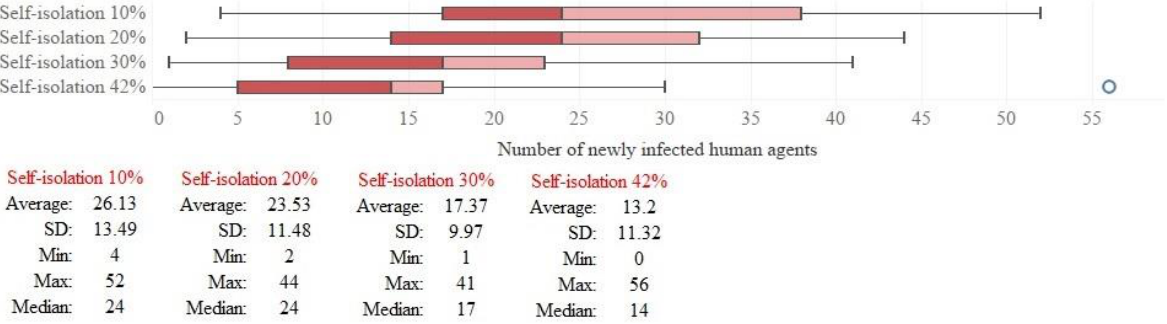
Figure 10. The number of newly infected human agents regarding four distinct values for the per- centage of infectious people observing the self-isolation intervention; each agent is a representative of 100 people.